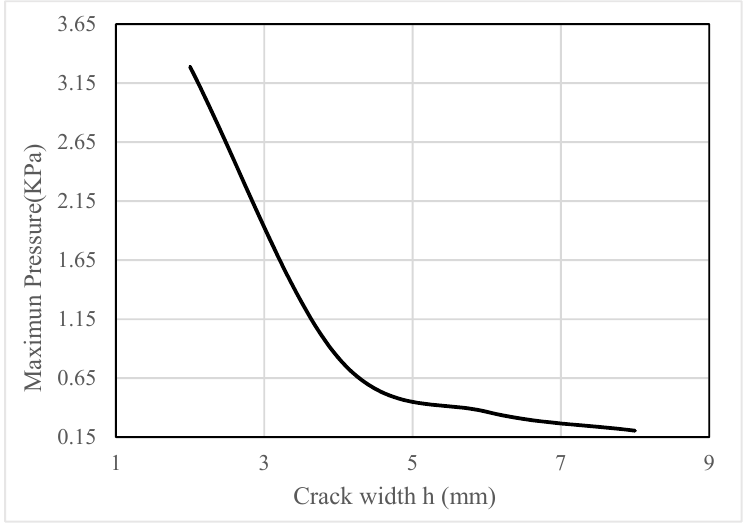
Figure 13. Relation curve between maximum pressure and fracture opening.